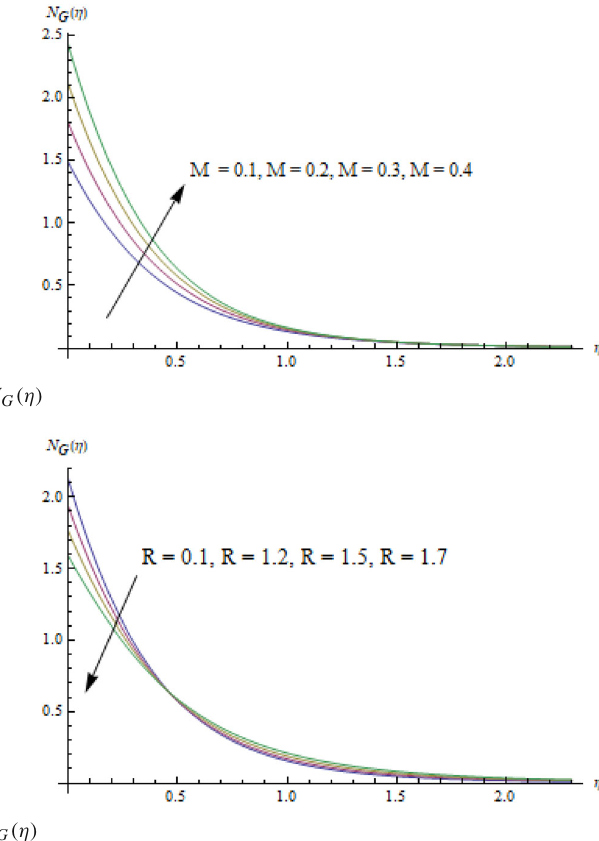
Fig. 35 Impact of R on N G (η)